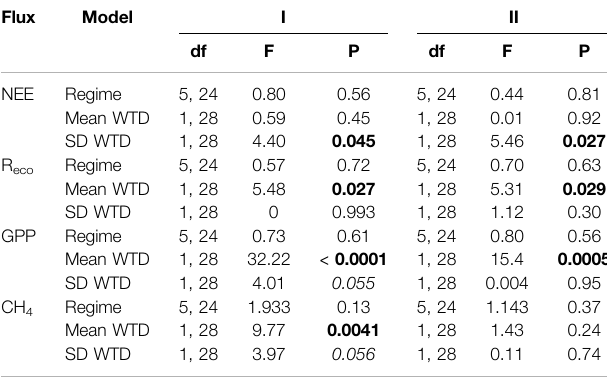
TABLE 3 | Outcome of separate linear regression models testing the in fl uence of precipitationregime(Regime), WTDmeanorSD(measuredduring phaseI)on cumulative net ecosystem exchange (NEE), ecosystem respiration (R eco ), gross primary productivity (GPP), and methane (CH 4 ) during the resistance phase (I, week 0 – 10), and resilience phase (II, week 10 –